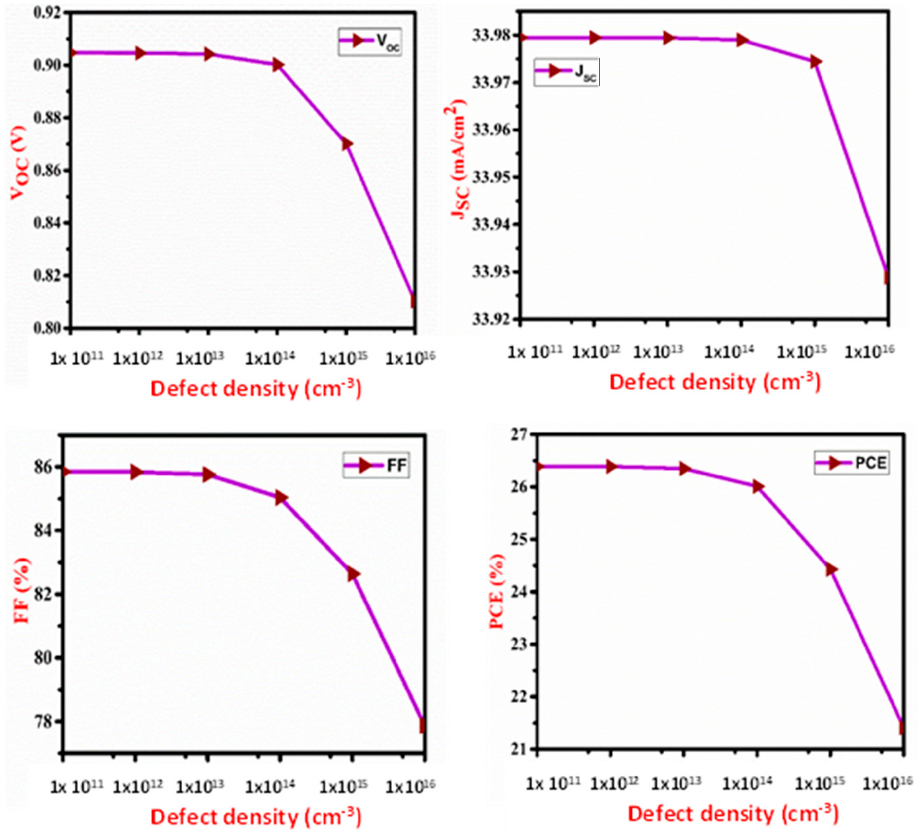
Figure 3. Impact of defect density of SnS layer on V OC , J SC , FF and PCE of the proposed cell. The absorber layer thickness and defect density varied from 100 to 1200 nm and from 10 11 to 10 16 cm − 3 , respectively. V OC decreases with an increase in thickness and defect den- sity of SnS but there is no effect of defect density on J SC below 10 15 cm − 3 due to an increase